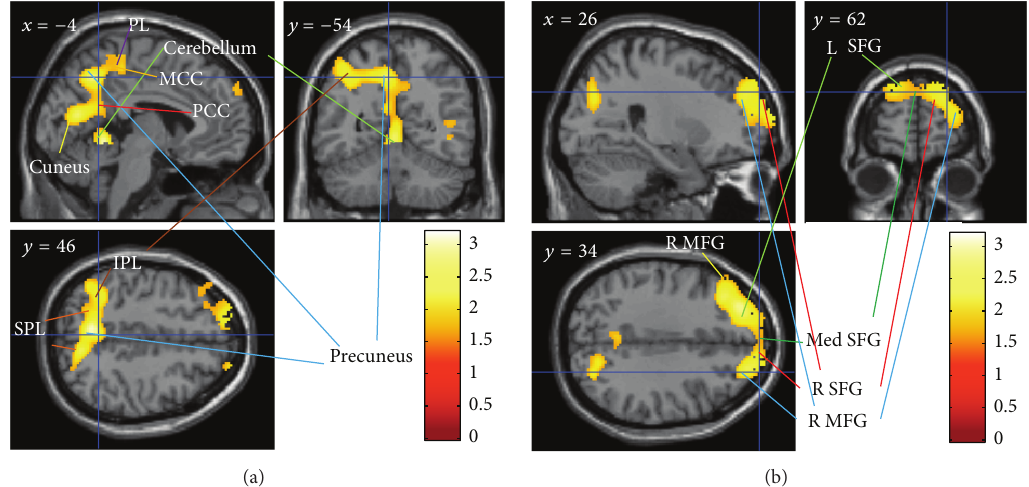
Figure 4: Effect of FSNC training on resting rCBF. The results are shown with 𝑃 < 0.05 , corrected for multiple comparisons at cluster size, with an underlying voxel-level of 𝑃 < 0.05 , uncorrected. FSNC training resulted in an increase in resting rCBF in an extended anatomical cluster in the posterior region (a) and in an extended anatomical cluster primarily located in the bilateral frontopolar areas (b). MCC: middle cingulate gyrus. PCC: posterior cingulate gyrus. IPL: inferior parietal lobule. SPL: superior parietal lobule. SFG: superior frontal gyrus. MFG: middle frontal gyrus. Med SFG: medial part of the superior frontal gyrus. PL: paracentral lobule. Table 3: Statistical values of clusters with a greater increase in resting rCBF in FSNC training as well as their subpeaks. 𝑇 score of the peak Corrected 𝑃 value Raw cluster size Area 𝑥 𝑦 𝑧 voxel (cluster) (mm 3 ) Posterior cluster [angular gyrus (B)/calcarine cortex (B)/middle and posterior cingulate gyrus (B)/posterior cingulate gyrus (B)/cuneus (B)/lingual gyrus (B)/middle and superior occipital lobe (B)/paracentral lobule (L)/parahippocampal gyrus (R)/inferior parietal lobule (L)/superior parietal lobule (B)/postcentral gyrus (L)/precuneus (B)/inferior and middle temporal lobe (R)/cerebellum (B)] Cerebellum 2